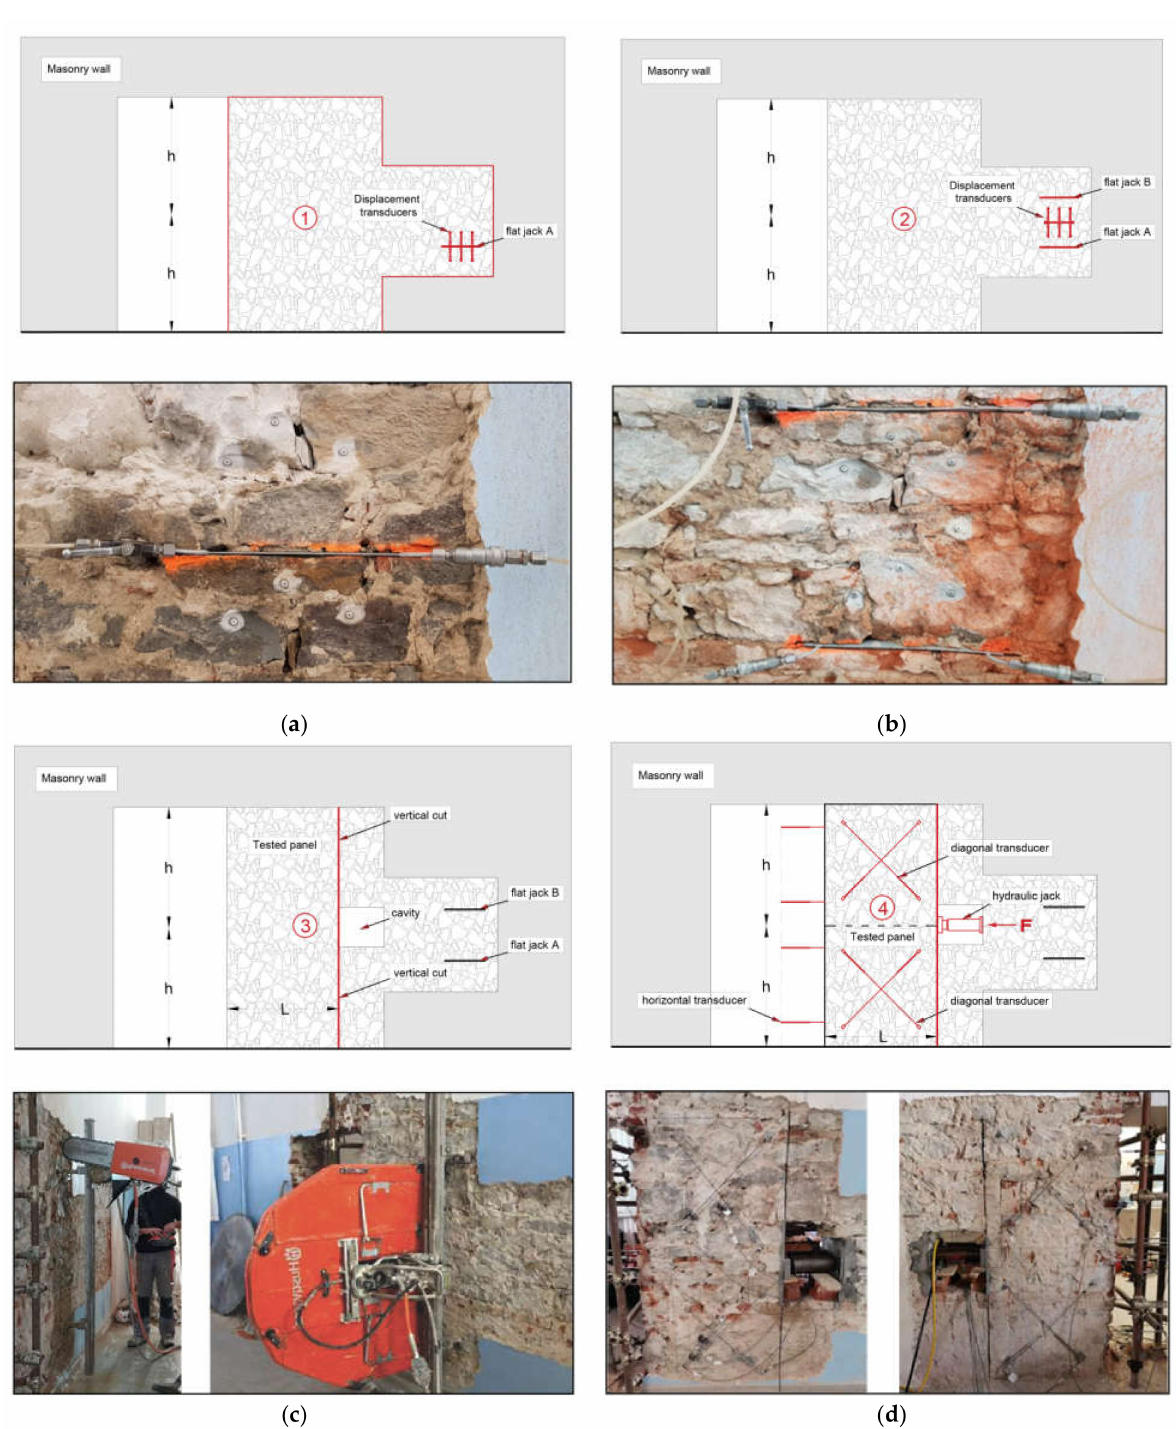
Figure 4. Sequence of relevant test phases: phase 1—removal of the plaster and performance of a single flat jack test ( a ), phase 2—preparation and performance of a double flat jack test ( b ), phase 3—realization of the vertical cut and making of a cavity in the wall to insert the hydraulic jack ( c ), phase 4—setup of the shear test with the placement of the measuring devices, horizontal and diagonal transducers ( d